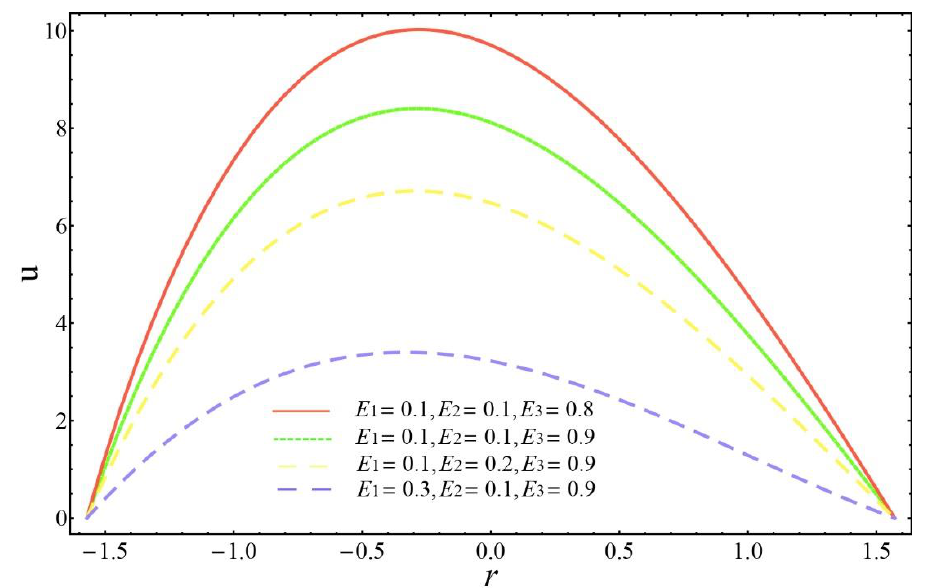
Figure 4. Variation of complaint wall parameters on u when 𝜖 = 0.6; 𝛽 = 0.01; 𝑘 = 2; 𝑥 = 0.2; 𝑡 = 0; 𝑁 𝑐 = 2; 𝑁 𝑟1 = 1; 𝑄 = 10.